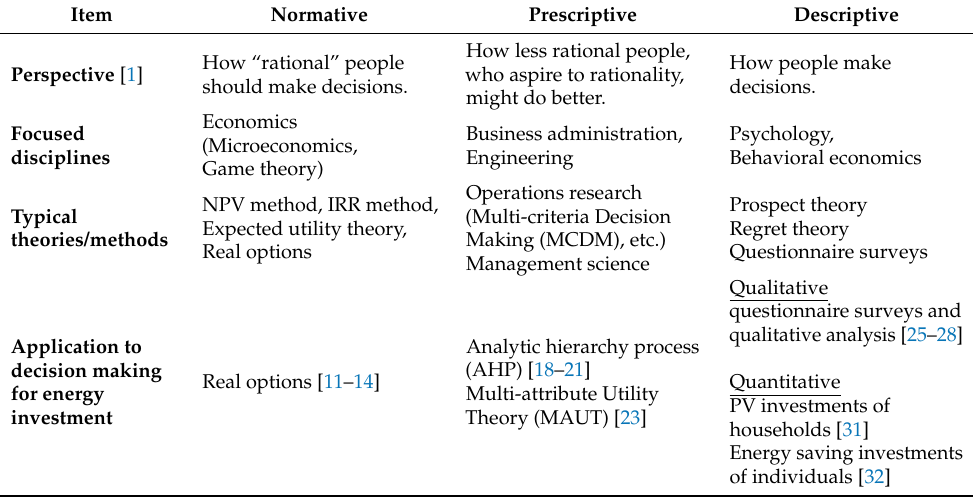
Table 1. Summary of approaches to decision-making in the field of energy